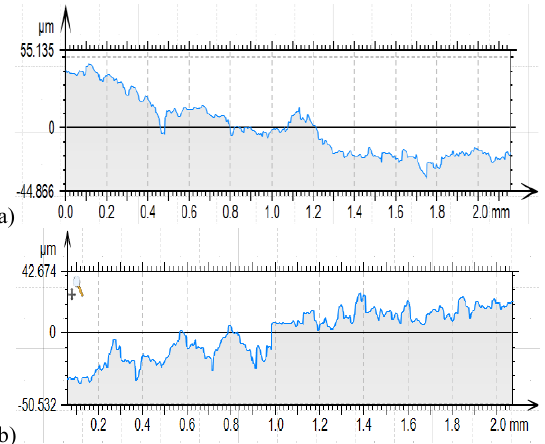
Fig. 7. The profile diagram of EN AW-2017A-T4 specimen subjected to bending loading, r=0, for a) the propagation area, b) the rupture area.